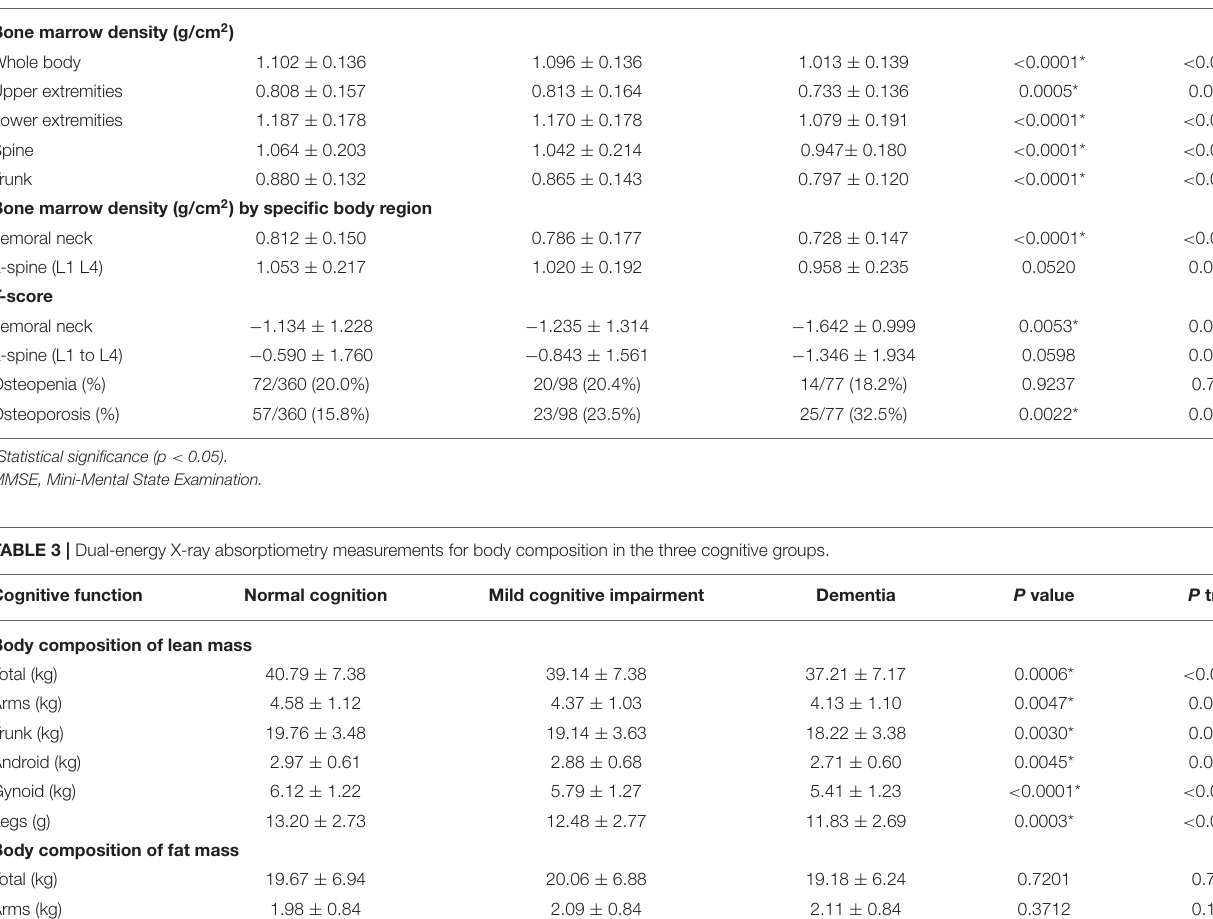
TABLE 2 | Dual-energy X-ray absorptiometry (DXA) measurements for bone marrow density in the three cognitive groups. Cognitive function